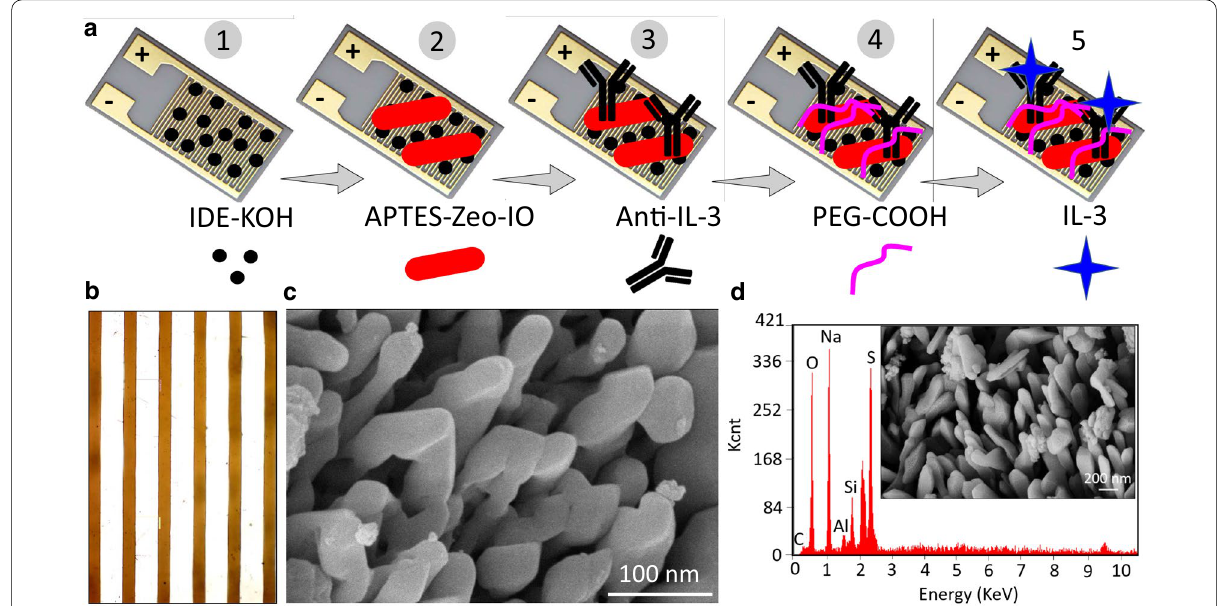
Fig. 1 a Schematic illustration of IL-3 identification on an anti-IL-3-modified capacitance sensing surface. APTMS-modified zeolite-iron was used to attach the capture antibody and then interacted with IL-3. PEG-COOH was used as the blocking agent. b Morphological analysis of the capacitance sensing surface by high-power microscopy. c Morphological analysis of zeolite-iron by FESEM. Nanomaterials were formed with a uniform distribution and in the longitudinal dimension. d EDX analysis. The presence of the main elements Si, Al, Fe, and O was found. The figure inset was obtained by FESEM with low